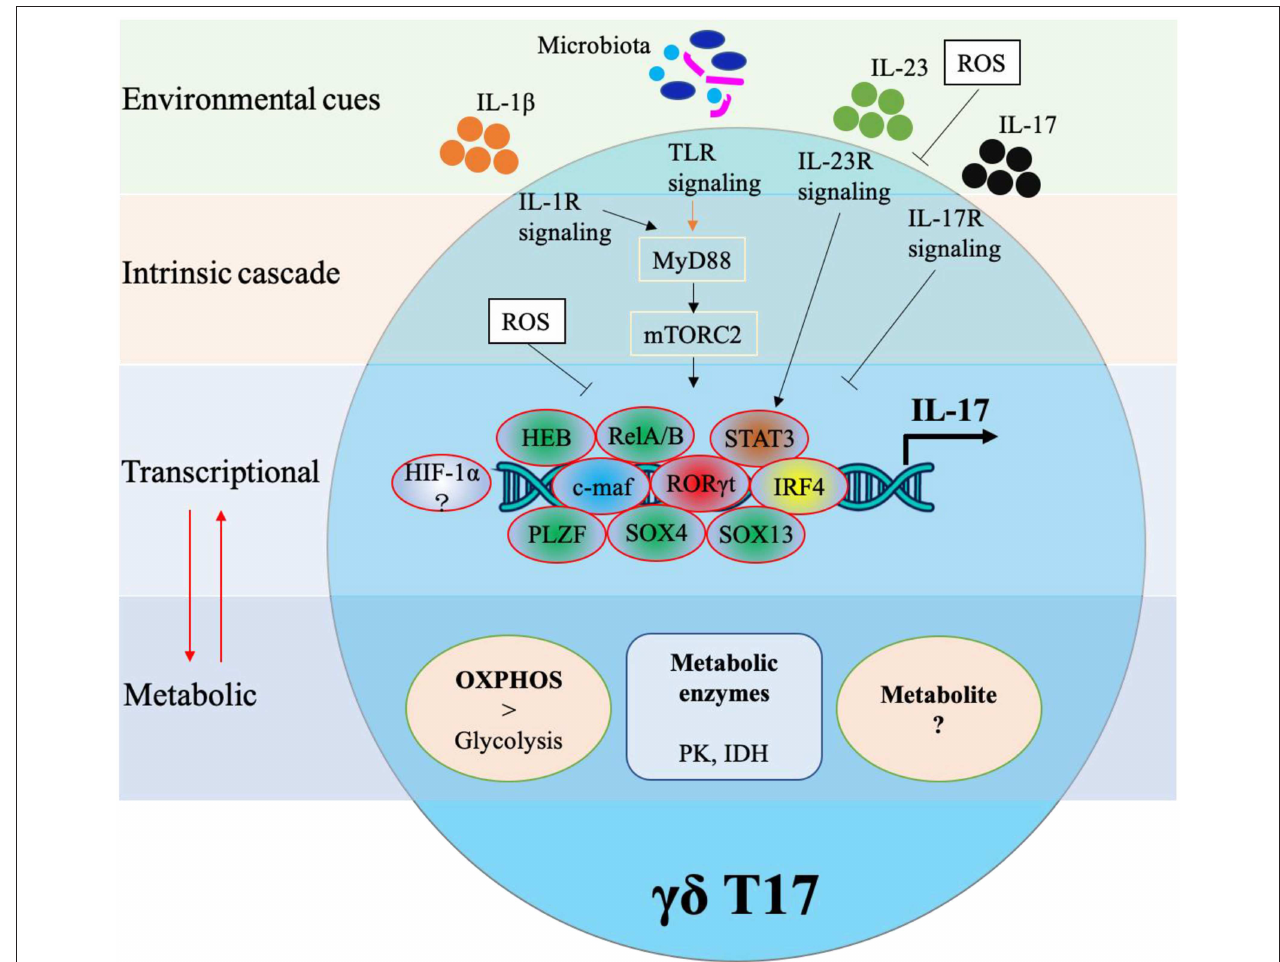
FIGURE 2 | Transcriptional and metabolic regulation of IL-17 production in murine γδ T